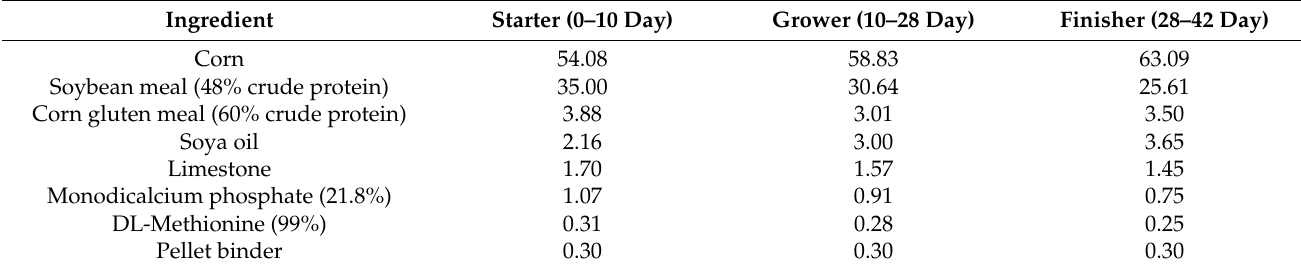
Table 1. Ingredient composition (%) and nutrient analysis of starter, grower and finisher